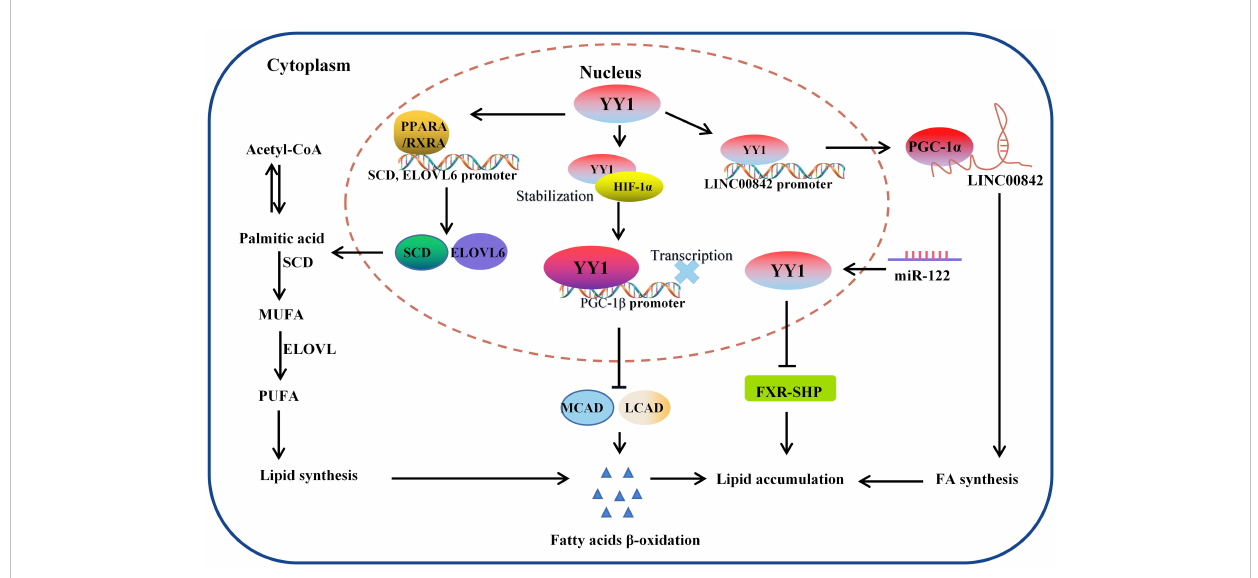
FIGURE 4 The molecular mechanism of YY1 regulating lipid metabolism. YY1 promotes triglyceride accumulation by regulating lipid metabolism-related molecule transcription. In this process, YY1 suppressed fatty acid b -oxidation, further inhibiting the expression of medium-chain acyl-CoA dehydrogenase (MCAD) and long-chain acyl-CoA dehydrogenase (LCAD) which is the key enzymes necessary for FAO. Additionally, miR-122 could promote lipid droplet formation and triacylglycerol (TG) accumulation in vitro by reducing the stability of YY1 mRNA and upregulating FXR-SHP signaling. Furthermore, YY1 also leads to lipid accumulation through the PPARA, RXRA/SCD, ELOVL6 signaling pathway and regulated the expression of LINC00842. LCAD, long-chain acyl-CoA dehydrogenase; MCAD, medium-chain acyl-CoA dehydrogenase; PGC-1 b : peroxisome proliferator- activated receptor gamma coactivator-1 b ; SCD: PGC-1 a : peroxisome proliferator-activated receptor gamma coactivator-1 a